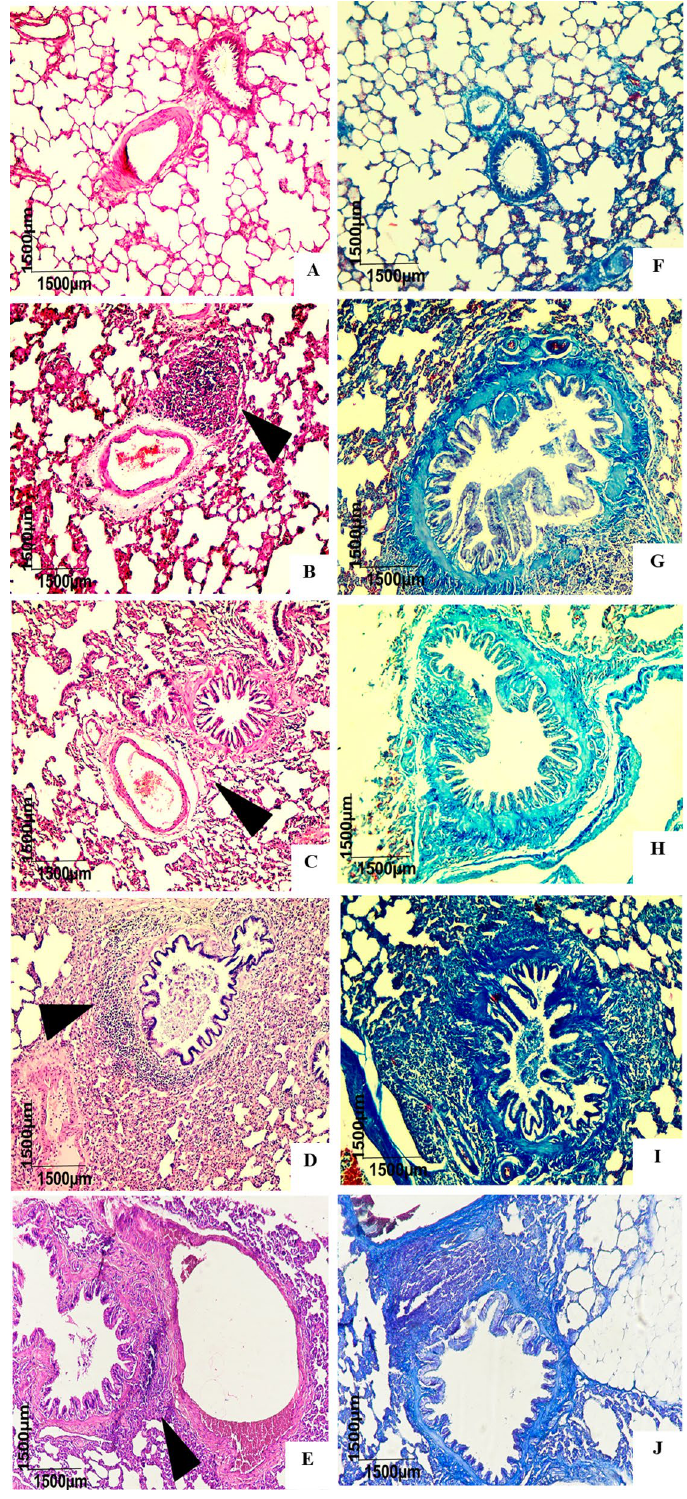
Figure 10. Photomicrograph of the lungs of rats from the Ctrl ( A , F ), Ob ( B , G ), Asth ( C , H ), Ob + Asth ( D , I ) and Ob + Asth + Dexa ( E , J ) stained with HE and Masson’s trichrome, respectively. Cell infiltrate (black